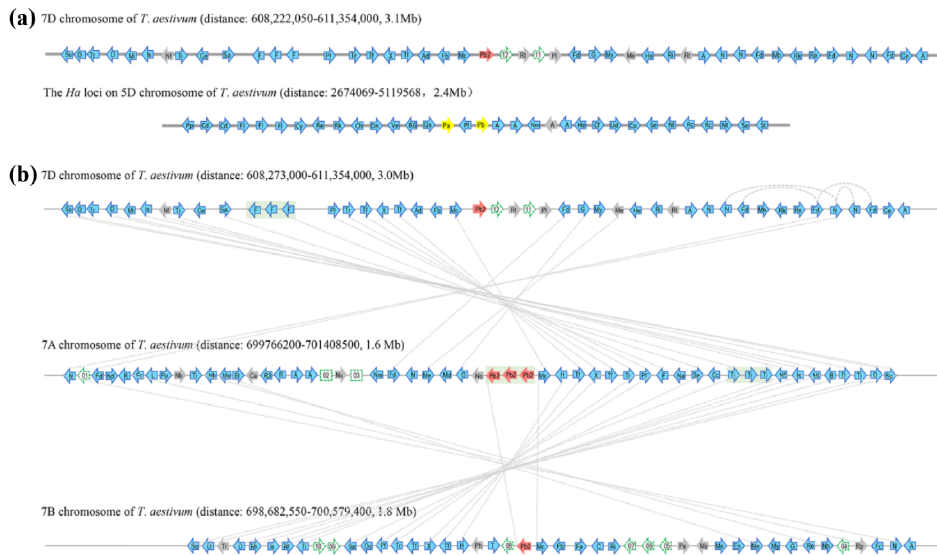
Figure 1. Syntenic alignments of bread wheat chromosomal segments that contains Pinb2-7D locus at 7DL and Ha locus at 5DS ( a ), and those that contains Pinb2-7D , Pinb2-7A , Pinb2-B at 7DL, 7AL and 7BL, respectively ( b ). Wheat chromosomes are represented as grey horizontal lines, whereas genes along the chromosome are represented as arrowheads. Pina-D1 and Pinb-D1 are represented as yellow arrowheads. Pinb2 are represented as red arrowheads, while the other protein-coding genes with high confidence annotations in the IWGSC RefSeq v1.0 bread wheat genome are represented as blue arrowheads. Homoeologous gene pairs are indicated as dotted lines connecting arrowheads. Tandem duplication of the three Pinb2-7A genes is shaded in the grey box. To simplify visualization, only high-confidence protein-coding genes are shown with their orders and orientations along the chromosomal segments, shown as the same in wheat genome assembly. The intergenic regions are not in proportion to the wheat genome assembly. For visualization, only abbreviations of the genes are labeled on the arrowheads, with their full names provided in Table